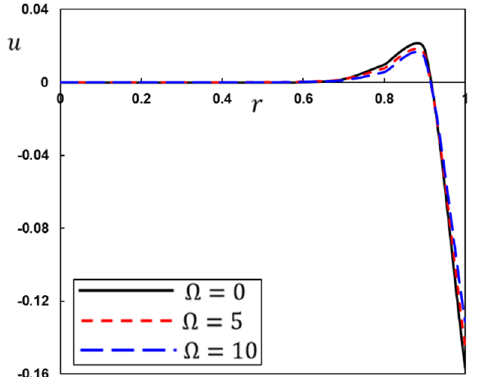
Figure 8. The displacement variation u for different rotation parameter Ω .